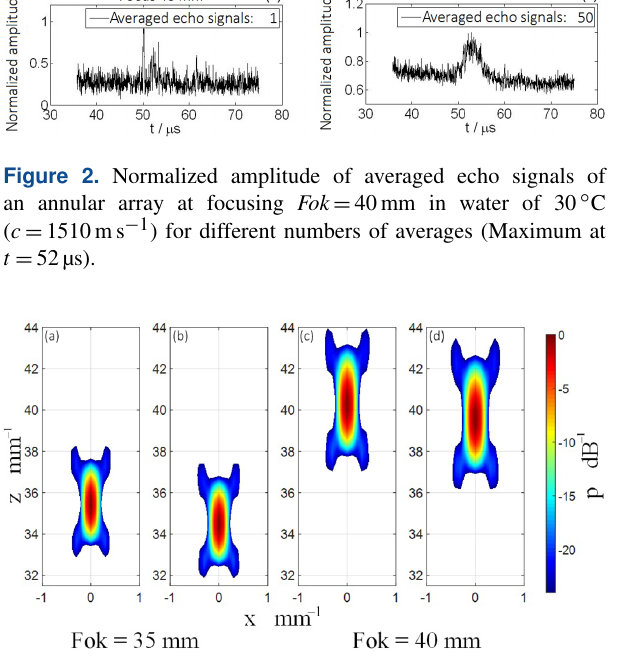
Figure 3. Calculated sound fields (focusing in send and receive mode) dependent on the sound velocity in the propagation medium for a curved 9MHz annular array at different control modes Fok